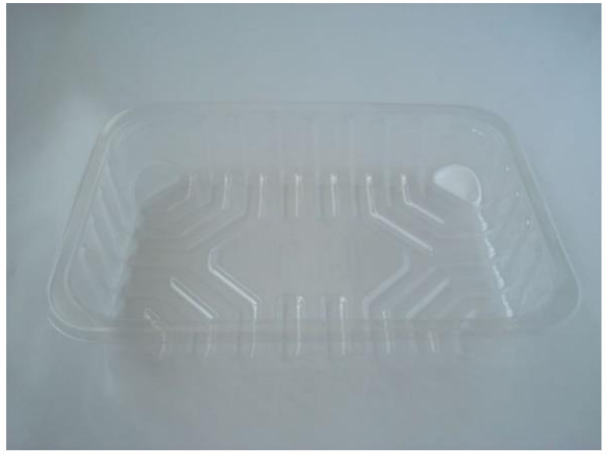
Figure 2. Picture of the B1825-45 tray